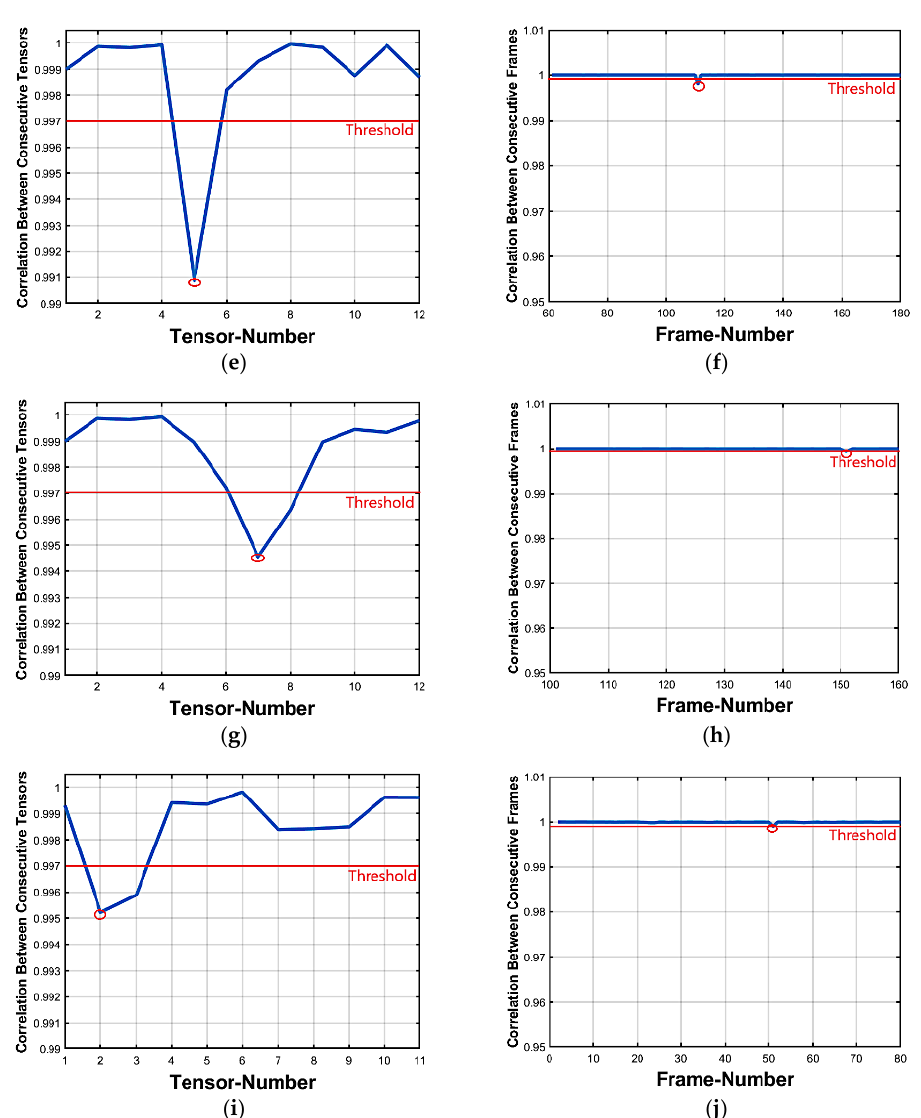
Figure 9. ( a , c , e , g , i ) deletion forgery detecting and ( b , d , f , h , j ) deletion forgery locating of 10, 20, 30, 40 and 50 forged frames respectively. Table 6. Deletion forgery detecting and locating. Results based on SVD-tensor features. Detecting